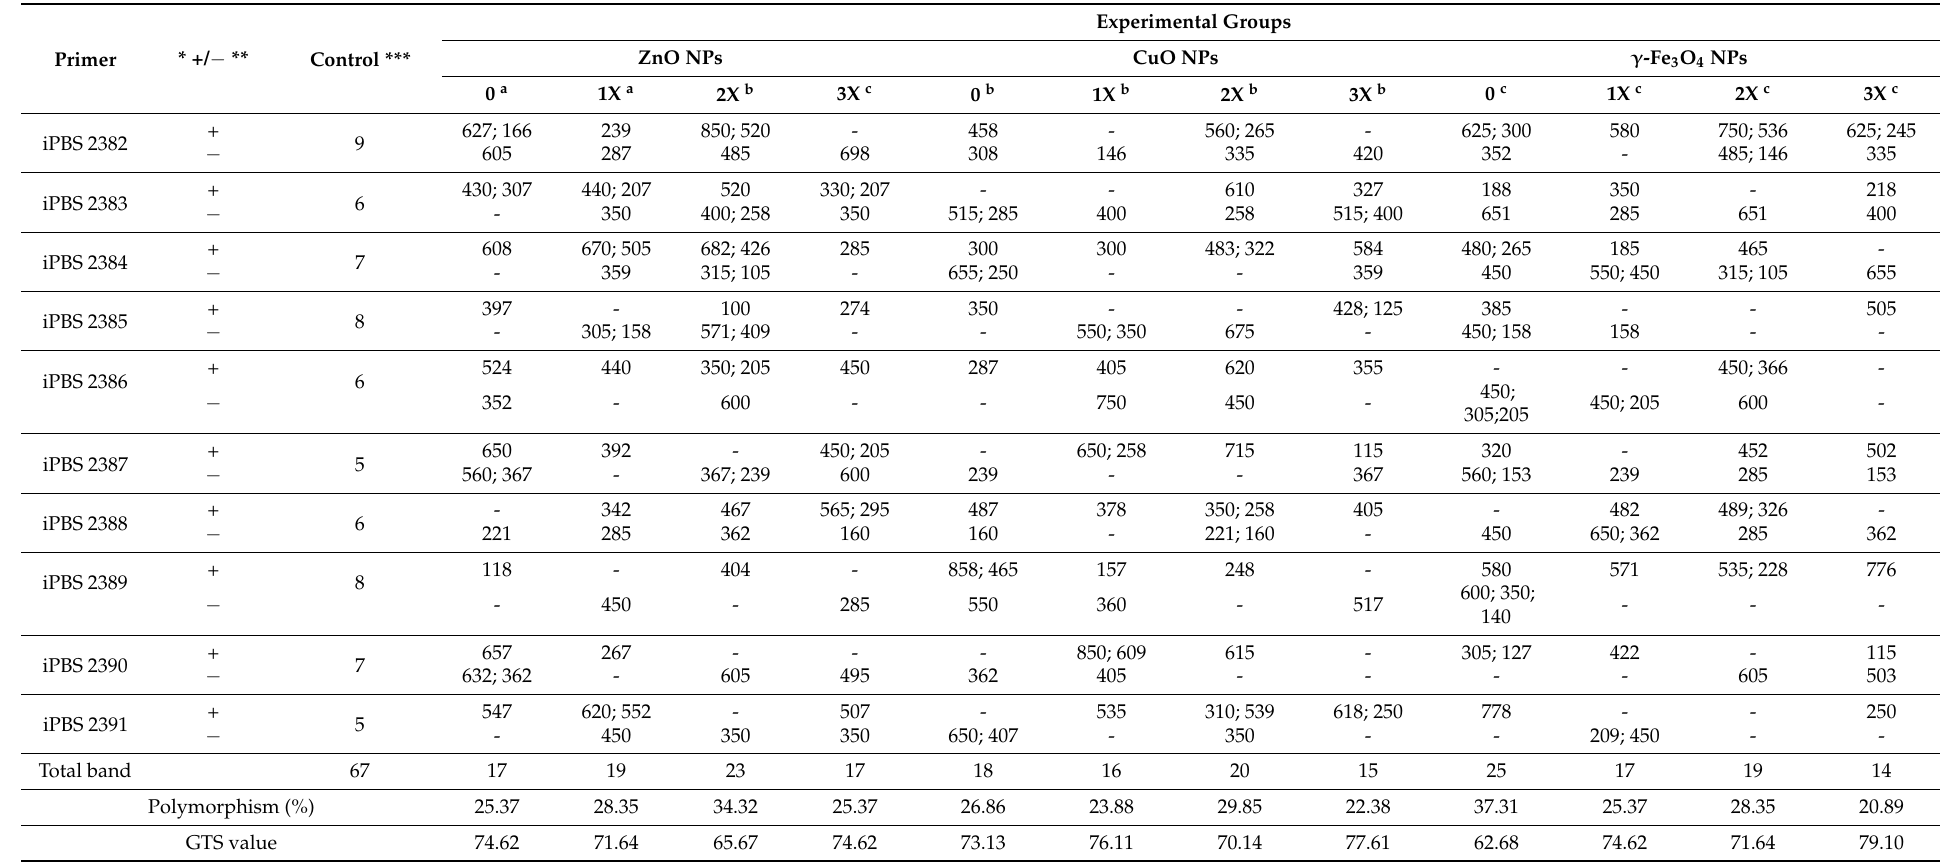
Table 1. Molecular sizes (bp) of present/absent bands in iPBS profiles under different nanoparticle treatments.